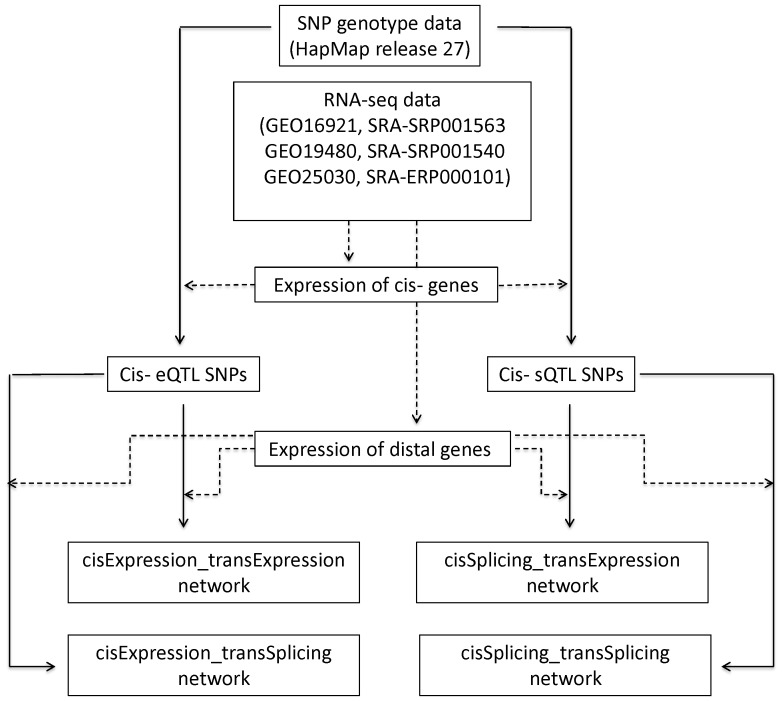
The schematic presentation of the study flow.